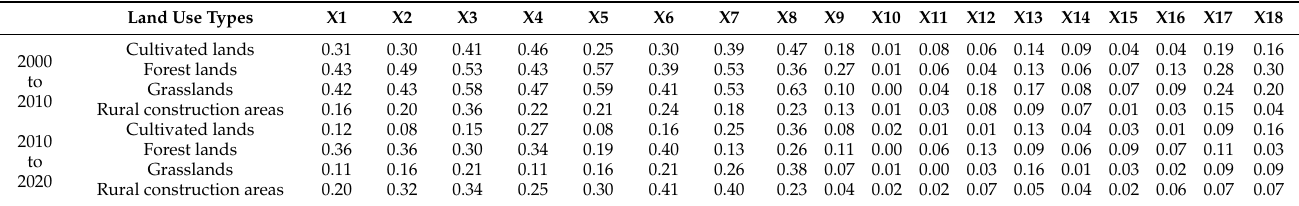
Table 2. Explanatory forces of LUCC drivers during 2010–2020 ( q